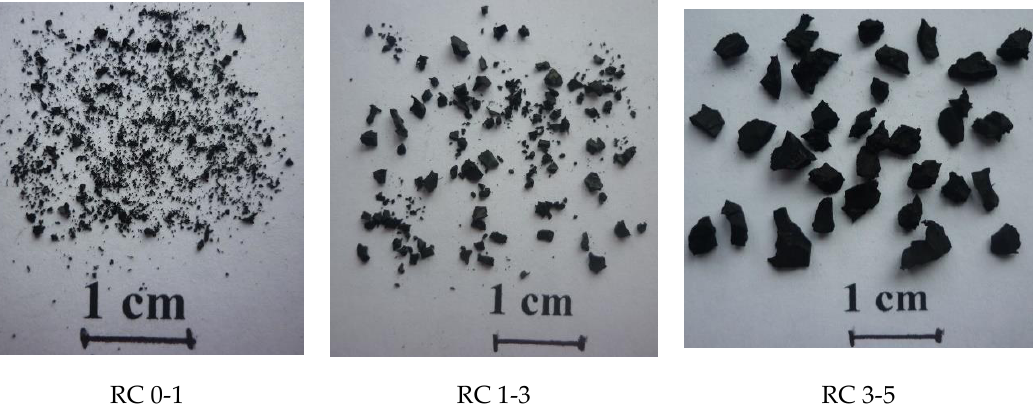
Figure 1. Photographs of crumb rubber fractions RC 0-1, RC 1-3, and RC 3-5.